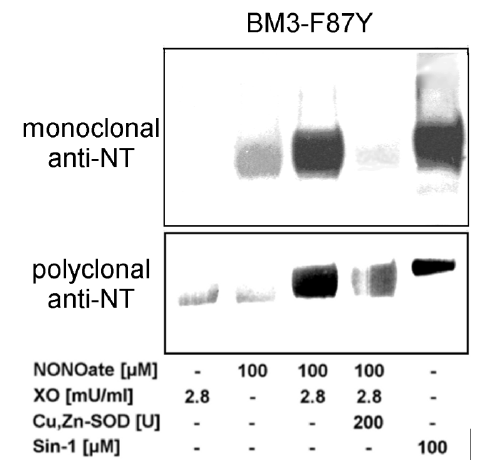
Figure 5. Effect of palmitate on the nitration of purified wildtype and F87Y variant by in situ generated peroxynitrite. ( A ) Detection of 3-nitrotyrosine in P450 P450 BM-3 F87Y variant by Western blot analysis using monoclonal and polyclonal F87Y variant (2 μ M) was treated anti-3-nitrotyrosine antibodies. P450 BM-3